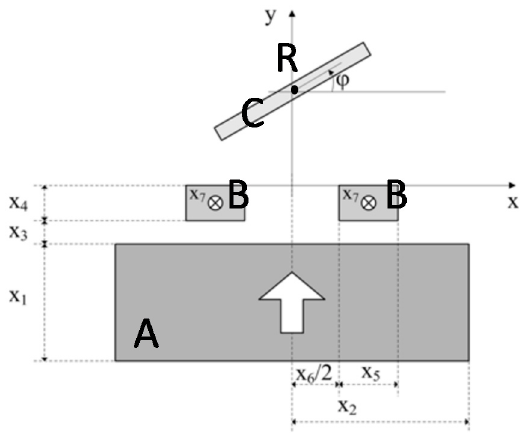
Figure 1. Geometry of the micromirror.